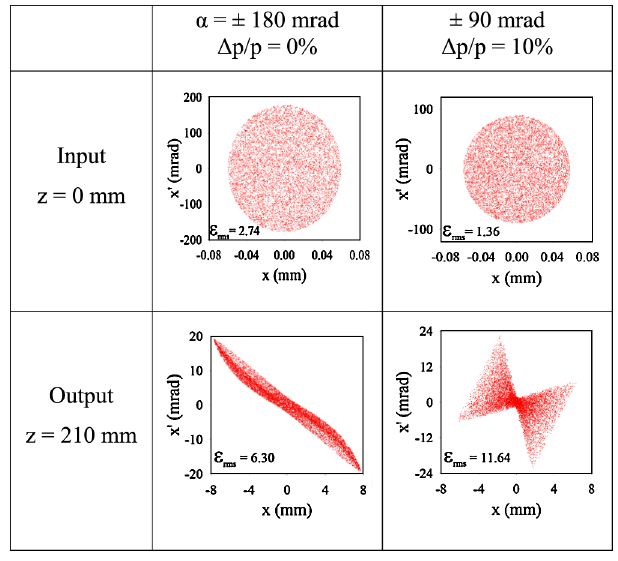
FIG. 5. Input and output distributions in x - x 0 for a monoener- getic beam with a divergence of (cid:2) 180 mrad (left), and for a beam with (cid:1) p=p ¼ (cid:2) 10% at (cid:2) 90 mrad